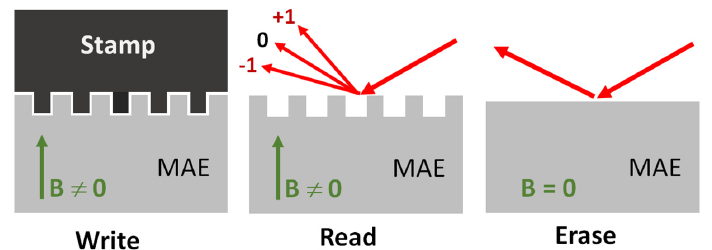
Figure 1. Schematic drawing of the writing (embossing), reading (optical diffraction) and erasure (transition to specular reflection) processes on the MAE surface.